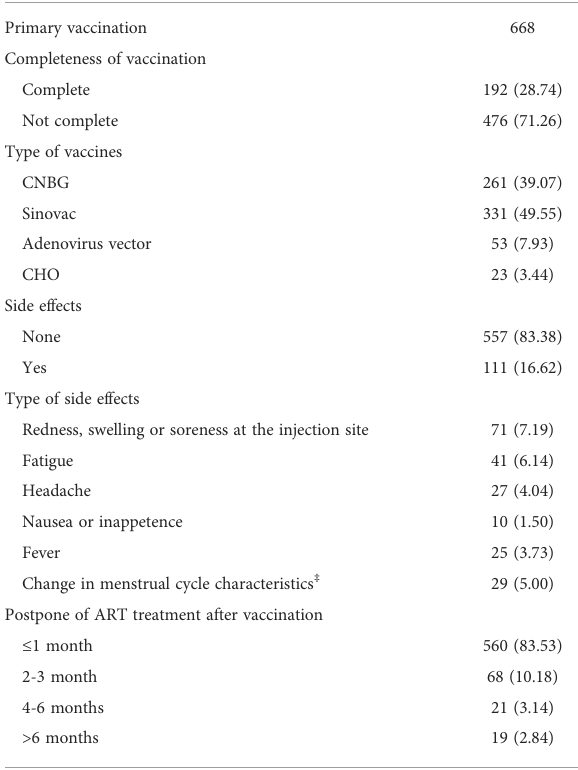
TABLE 4 Information on the primary